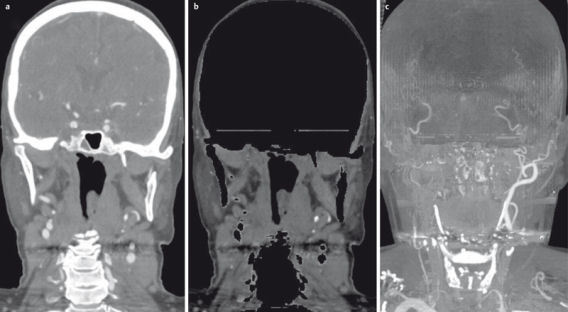
Dual-source CT of the midface.a) Fusion image of the 80 kV and 120 kV datasets.b) Automatic bone removal based on the different attenuation of bone in the two datasets.c) MIP reconstruction of the automatically segmented vessels.